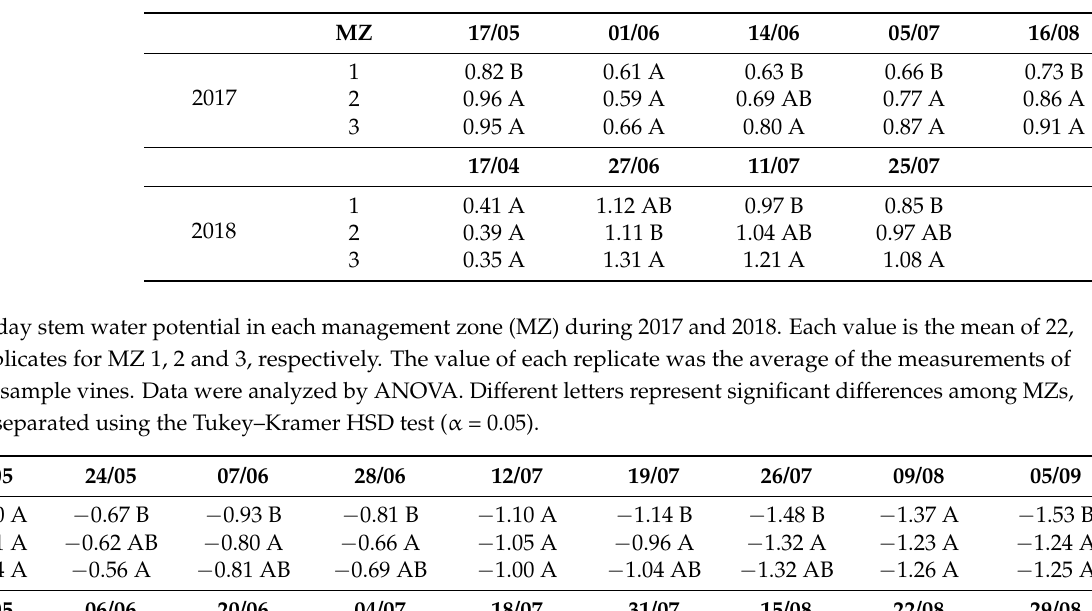
Table A1. Leaf area index in each management zone (MZ) during 2017 and 2018. Each value is the mean of 22, 28 and 10 replicates for MZ 1, 2 and 3, respectively. The value of each replicate was the average of the measurements of two adjacent sample vines. Data were analyzed using ANOVA. Different letters represent significant differences among MZs, means were separated using the Tukey–Kramer HSD test ( α = 0.05).